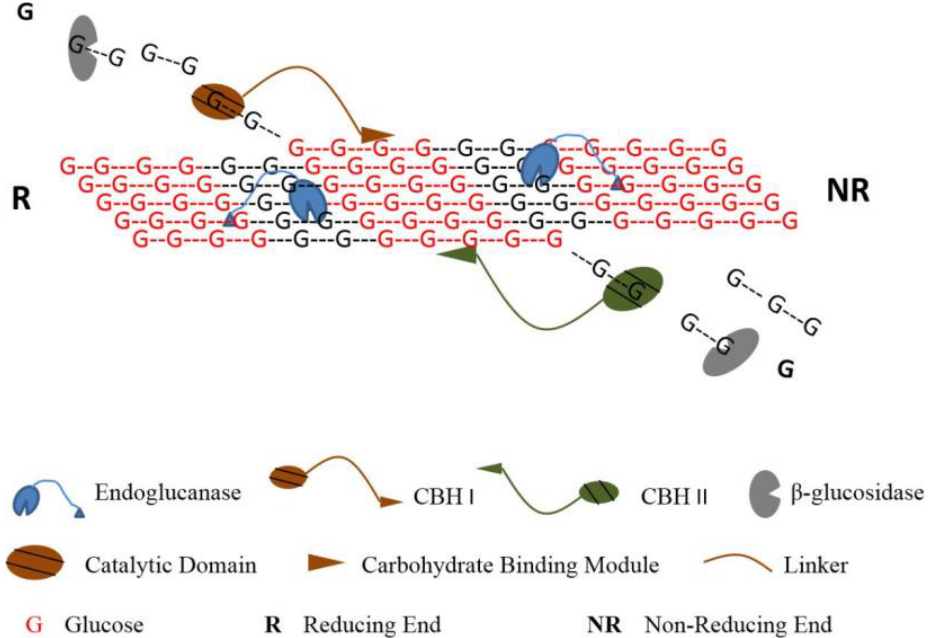
Figure 3. Simplified schematic of the action of different cellulases on cellulose chains (reproduced from Kumar and Murthy [20] with permission from BioMed Central Ltd., 2013).